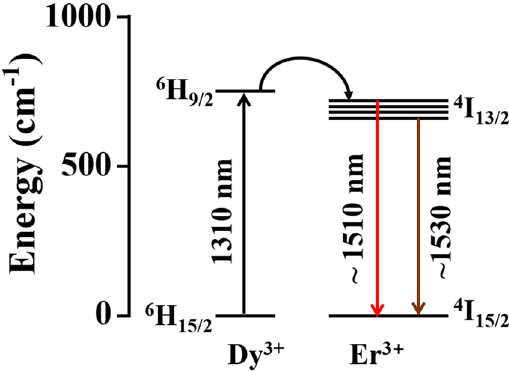
Figure 10. Energy transfer of Dy-Er ions while pumped at 1310